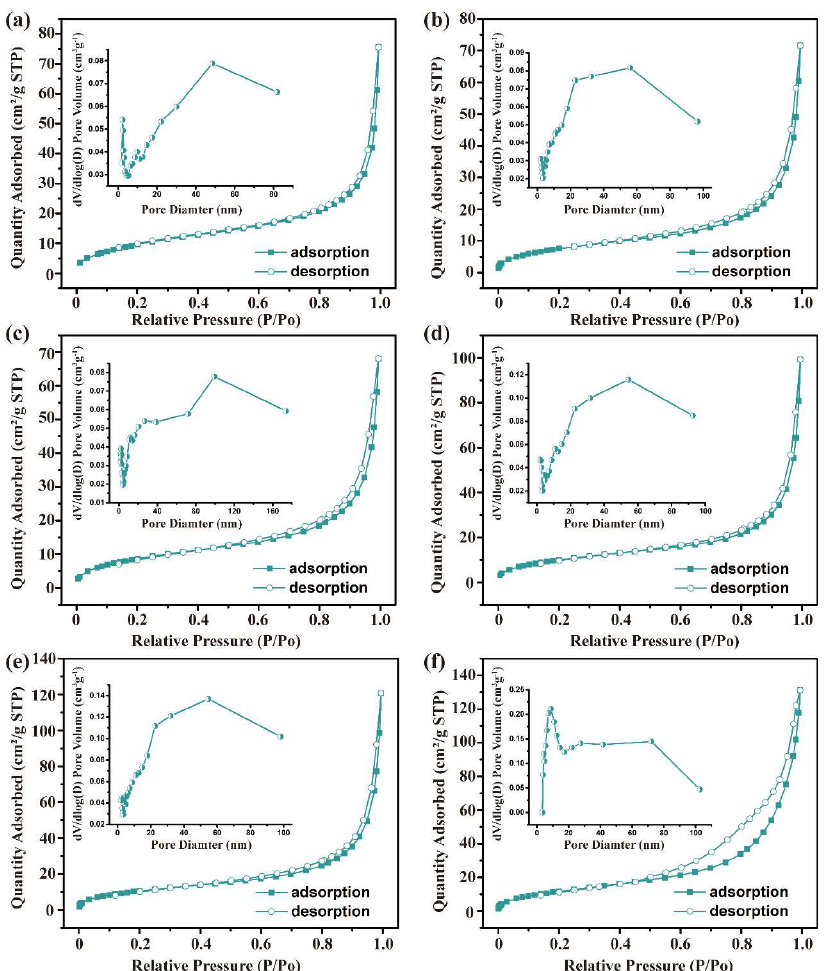
Figure 2. N 2 absorption–desorption isotherm of trypsin/Zn 3 (PO 4 ) 2 hybrid nanoflowers prepared by adding the following amounts of trypsin: ( a ) 0 g, ( b ) 0.01 g, ( c ) 0.025 g, ( d ) 0.05 g, ( e ) 0.1 g and ( f ) 0.25 g. The inset is pore-size distribution curve.